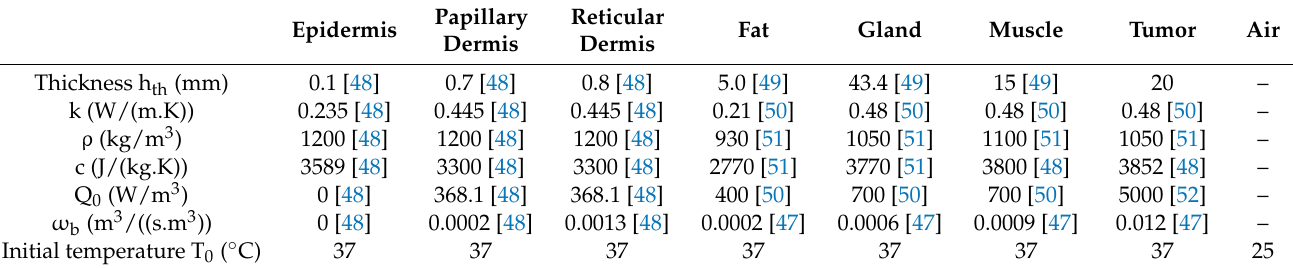
Figure 6. Multi-layered axisymmetric 2D breast model. Table 3. The physical properties of each tissue and the breast